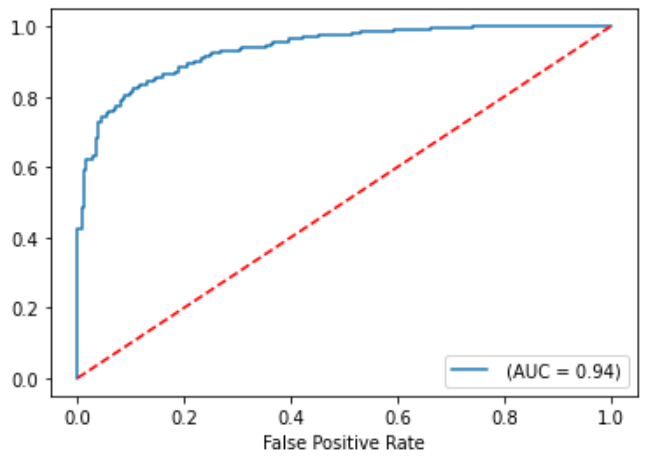
Table 2 . Evaluation metrics for COVID-19 severity and survival models without comorbidities in the training data .